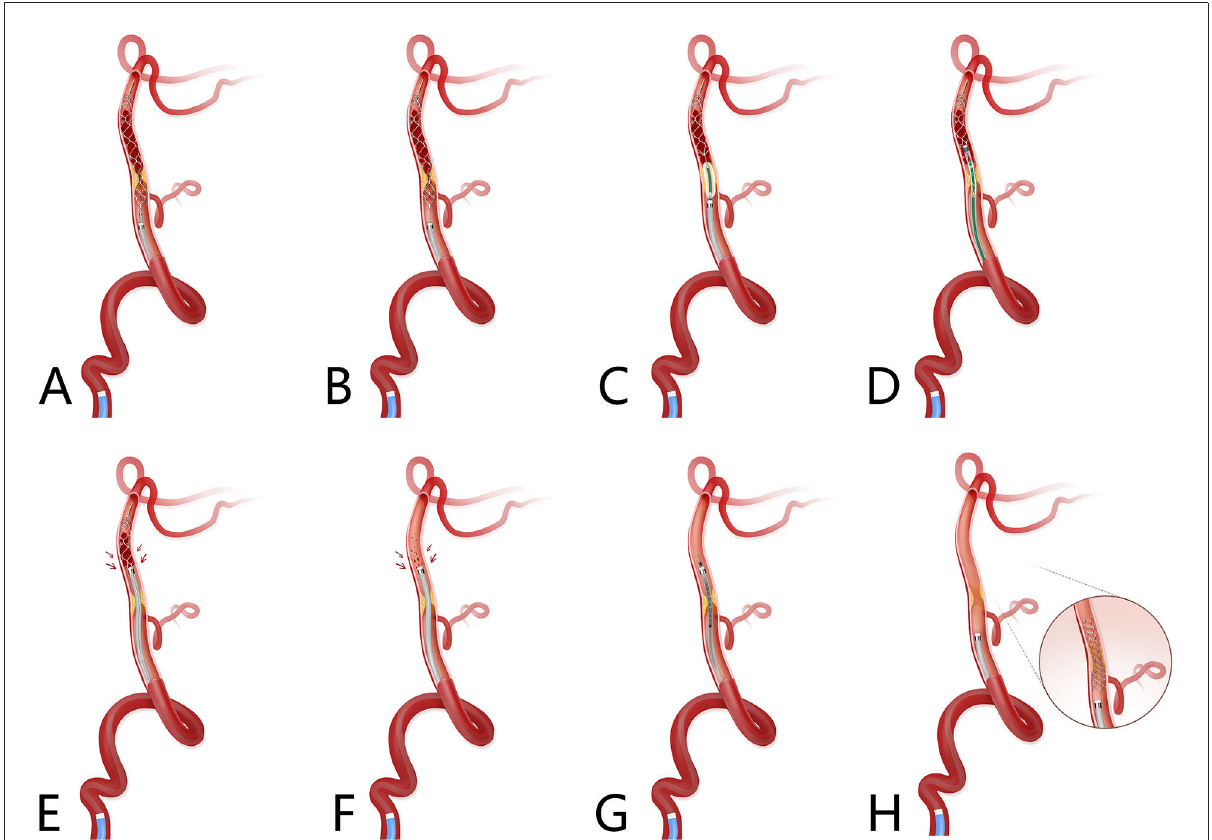
FIGURE1 Schematic diagram of the Balloon AngioplaSty with the dIstal protection of Stent retriever (BASIS) technique. Basilar artery ICAS-related occlusion with thrombus formed distal to the stenotic site. (A) A microcatheter was navigated through the area of total occlusion to the distal patent artery, microcatheter first pass effect was performed to ascertain ICAS-related occlusion; microwire was retrieved while microcatheter stay at distal of occlusion site and retrieval stent, of which the diameter of wire was 0.014 inch, was deployed at the occlusion site, which fully covered the lesion and thrombus. (B) Microcatheter was withdrawn while stent was in place. (C) A suitable balloon was advanced into the stenotic site through wire of retrieval stent, and the stent was partially retrieved; then the balloon was inflated. (D) Aspiration catheter was inserted through the stenotic site when the balloon was deflated. (E) The stent retriever was withdrawn under continuous manual negative pressure exerted with a 50-ml locked syringe without changing the position of the aspiration catheter. (F) Continuous aspiration was performed while totally withdrawing the stent retriever and there was blood flow from the aspiration catheter. (G) Stent retriever was redeployed at the lesion site; then aspiration catheter was retrieved to the proximal site under continuous aspiration via 50-ml locked syringe. (H) Angiography was performed to determine the stenosis grade and reperfusion grade. If a successful reperfusion grade could be maintained, the stent was retrieved via a microcatheter and withdrawn, if successful reperfusion could not be achieved and/or residual stenosis was high, angioplasty via balloon could be reperformed, in some clinical scenarios of stent implantation. ICAS, indicates intracranial